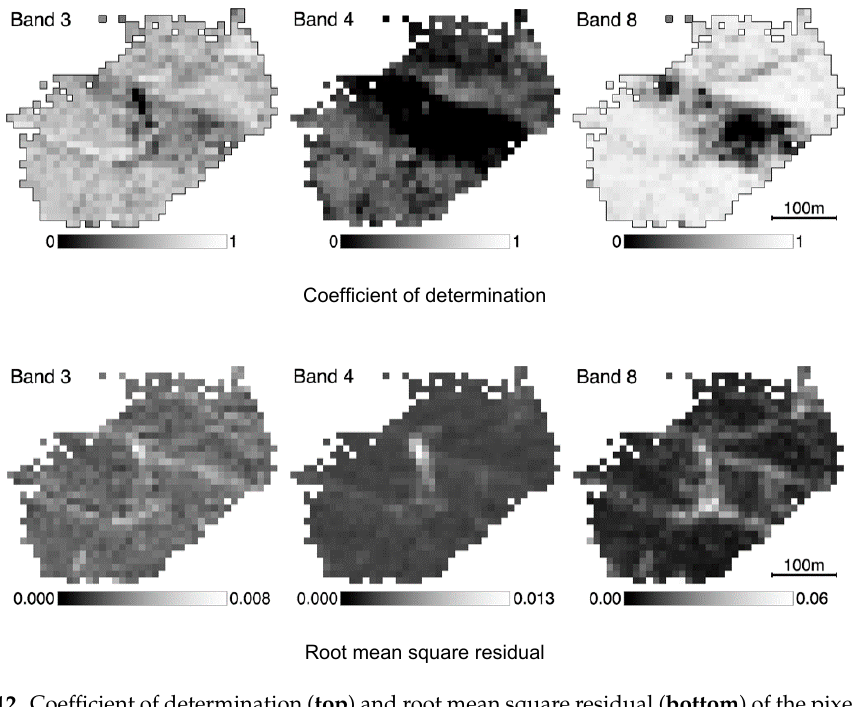
Figure 12. Coefficient of determination ( top ) and root mean square residual ( bottom ) of the pixel-based linear regression of reflectance against the sunlit fraction.